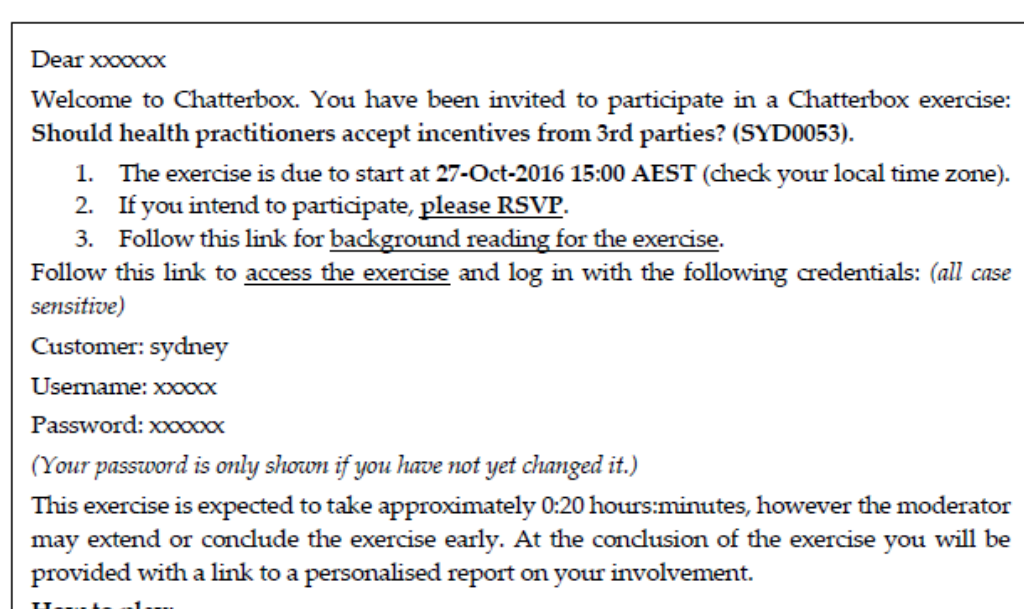
Figure 1. An example of the introductory email for a virtual human continuum (VHC) session.